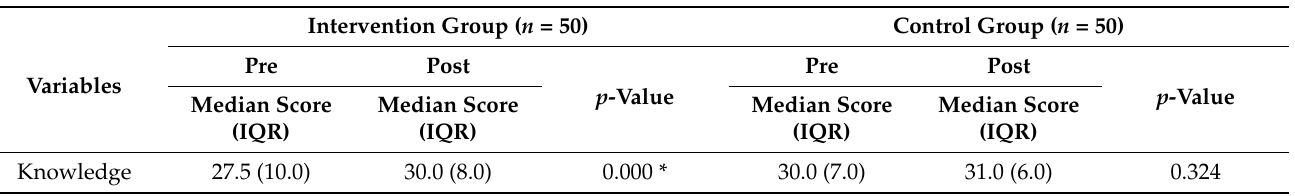
Table 3. Knowledge score before and after intervention among respondents ( n = 100).